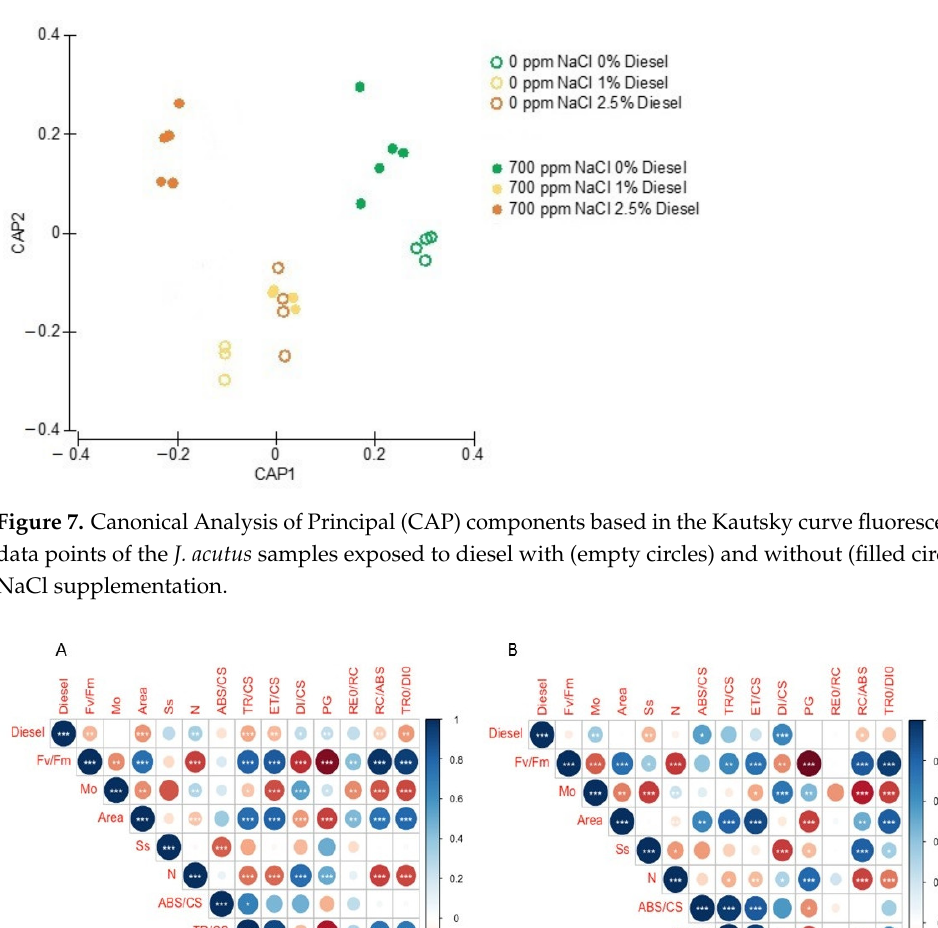
Figure 7. Canonical Analysis of Principal (CAP) components based in the Kautsky curve fluores- cence data points of the J. acutus samples exposed to diesel with (empty circles) and without (filled circles) NaCl supplementation.